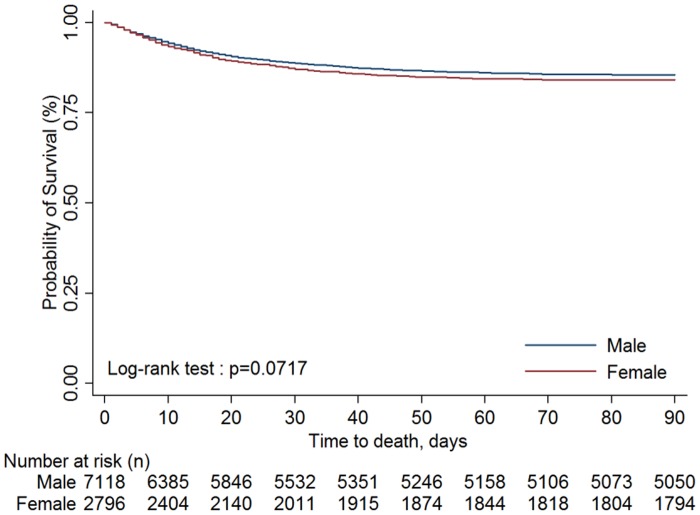
Time-to-event curves by genders for all-cause mortality up to 90 days.The event rate represents Kaplan-Meier estimates; log-rank test: p = 0.0717.